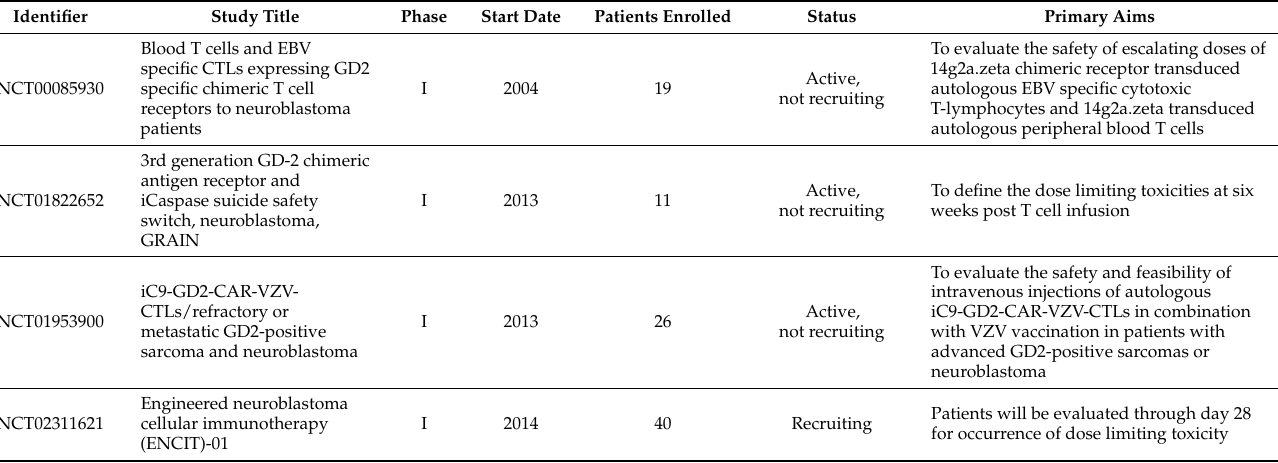
Table 4. Ongoing clinical trials using CAR T